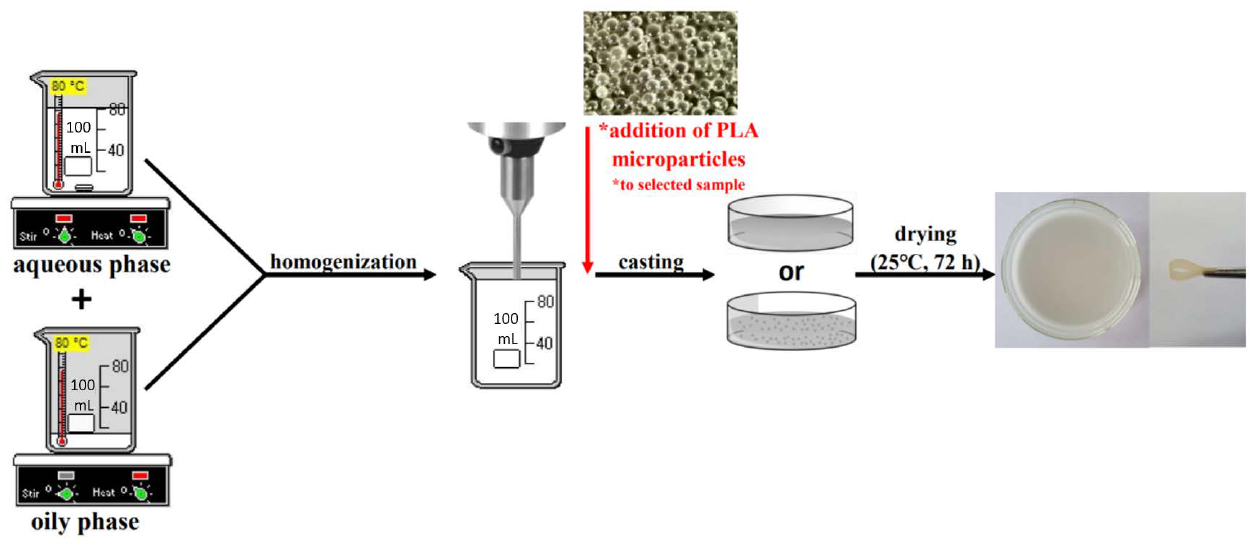
Figure 2. The scheme of production of emulsion